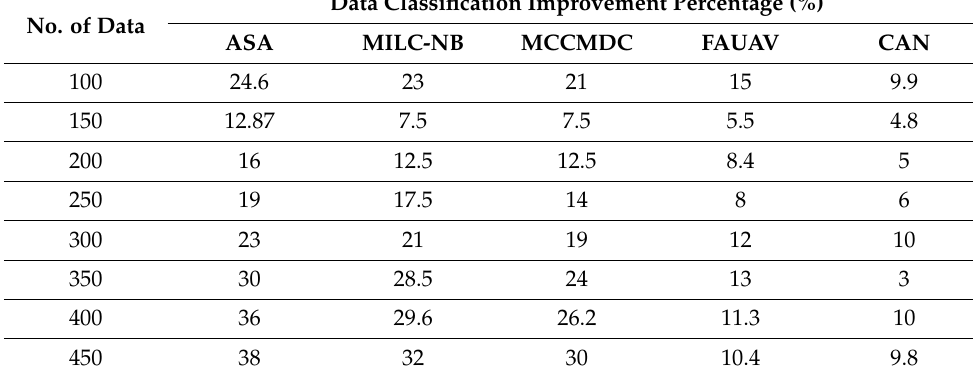
Figure 7. The power energy consumption after data obfuscation. Table 3 and Figure 8 of this research: In terms of data classification improvement per- centage in the proposed scenario, the proposed method has improved Data classification by about 3.48% compared with the MILC-NB algorithm, 5.66% compared with the MCCMDC algorithm, 14.48% compared with the FAUAV algorithm, and about 17.62% compared with the CAN approximately 69.34% compared with the Data classification improvement percentage Analysis on ASA algorithm. Table 3. Data classification improvement percentage Analysis. Data Classification Improvement Percentage (%) No. of Data